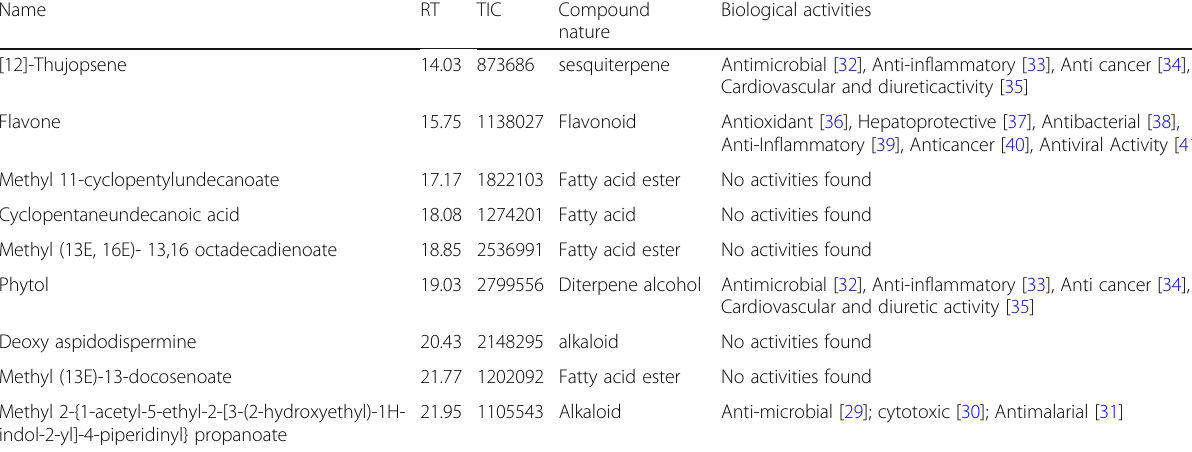
Table 3 Phytochemicals present in the methanolic extract of naturally grown L. cruciata and their biological